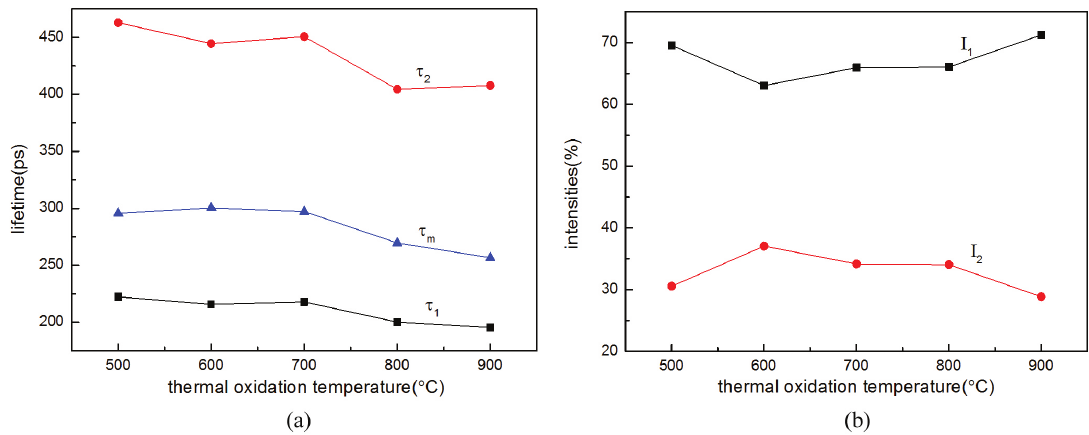
Figure 5. The positron lifetime components τ (a) The positron lifetime, (b) The relative